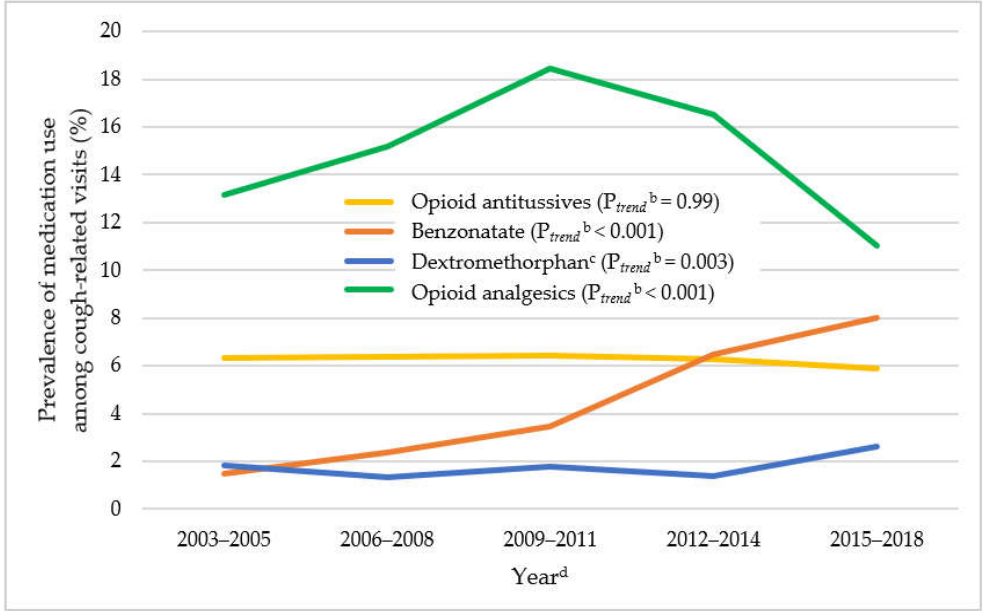
Figure 3. Trends in medication use among adult cough-related visits in ED setting: 2003–2018